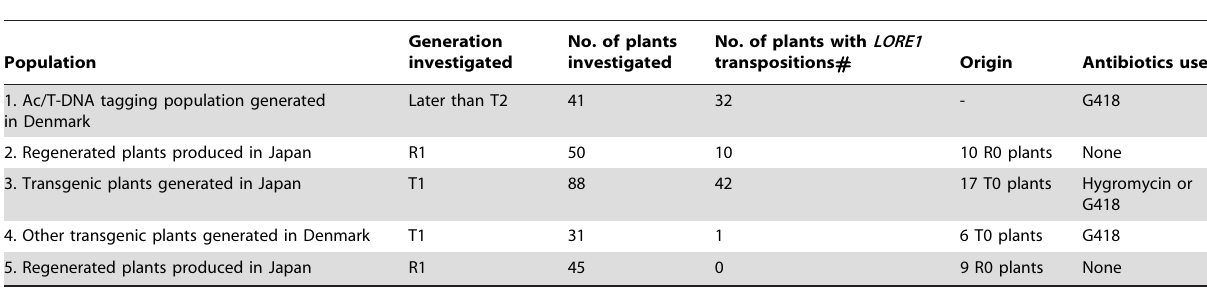
Table 1. LORE1 transpositions in regenerated plant